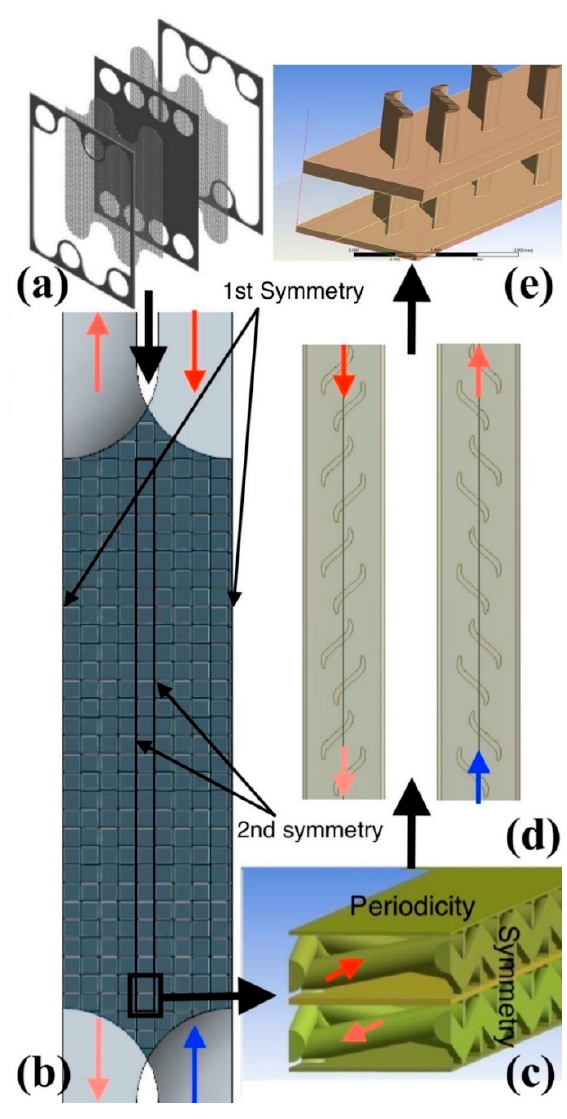
Figure 1. Wire-net brazed heat exchanger arrangement ( a ); microchannels with wire-net perturbators ( b ); Conjugate Heat Transfer (CHT) domain ( c ); wire-net microchannels replaced by S-shaped perturbators ( d ); CHT domain ( e ).